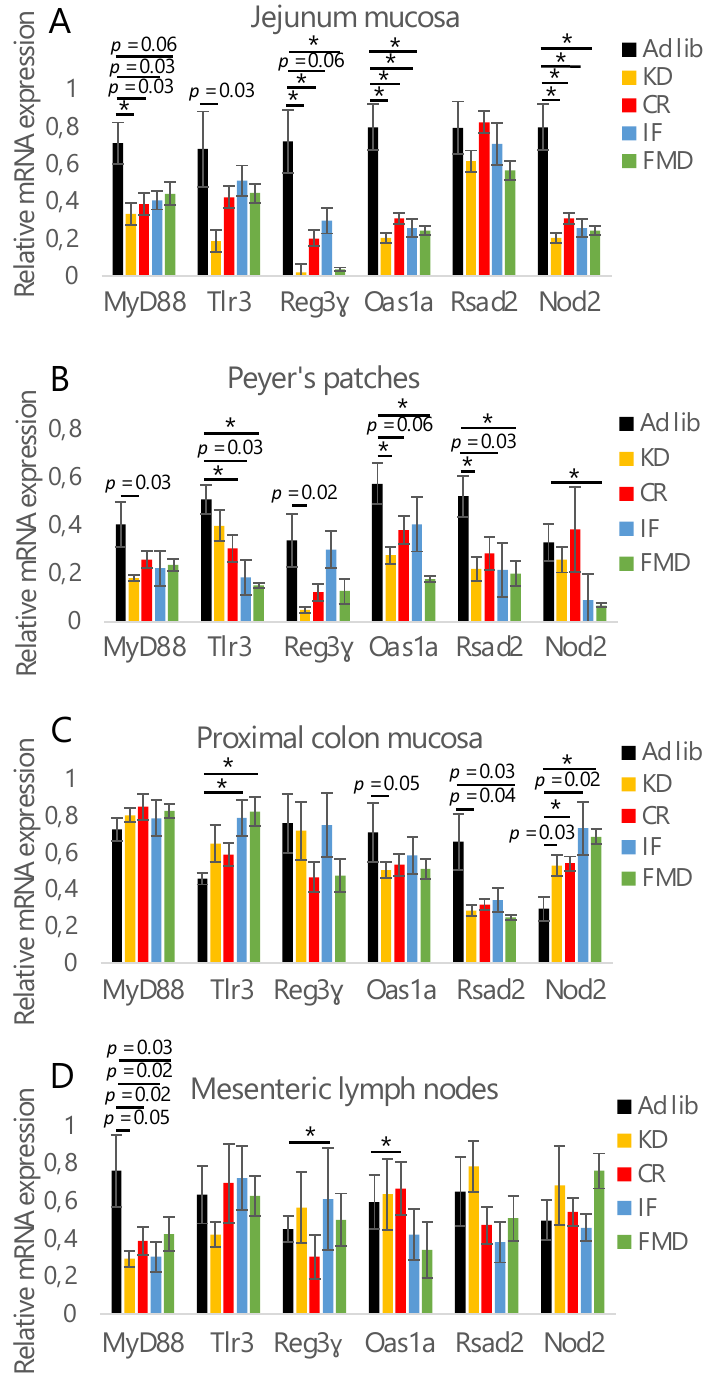
Figure 2. Restrictive diets reduce the expression of antimicrobial factors. The mRNA expression of microbiota-related factors was measured in the mucosa of the jejunum ( A ), Peyer’s patches ( B ), proximal colon mucosa ( C ), and mesenteric lymph nodes ( D ). The groups were compared using ANOVA followed up by Tukey’s post-hoc test. * p < 0.01; n = 6–8. Error bars indicate ± SEM.